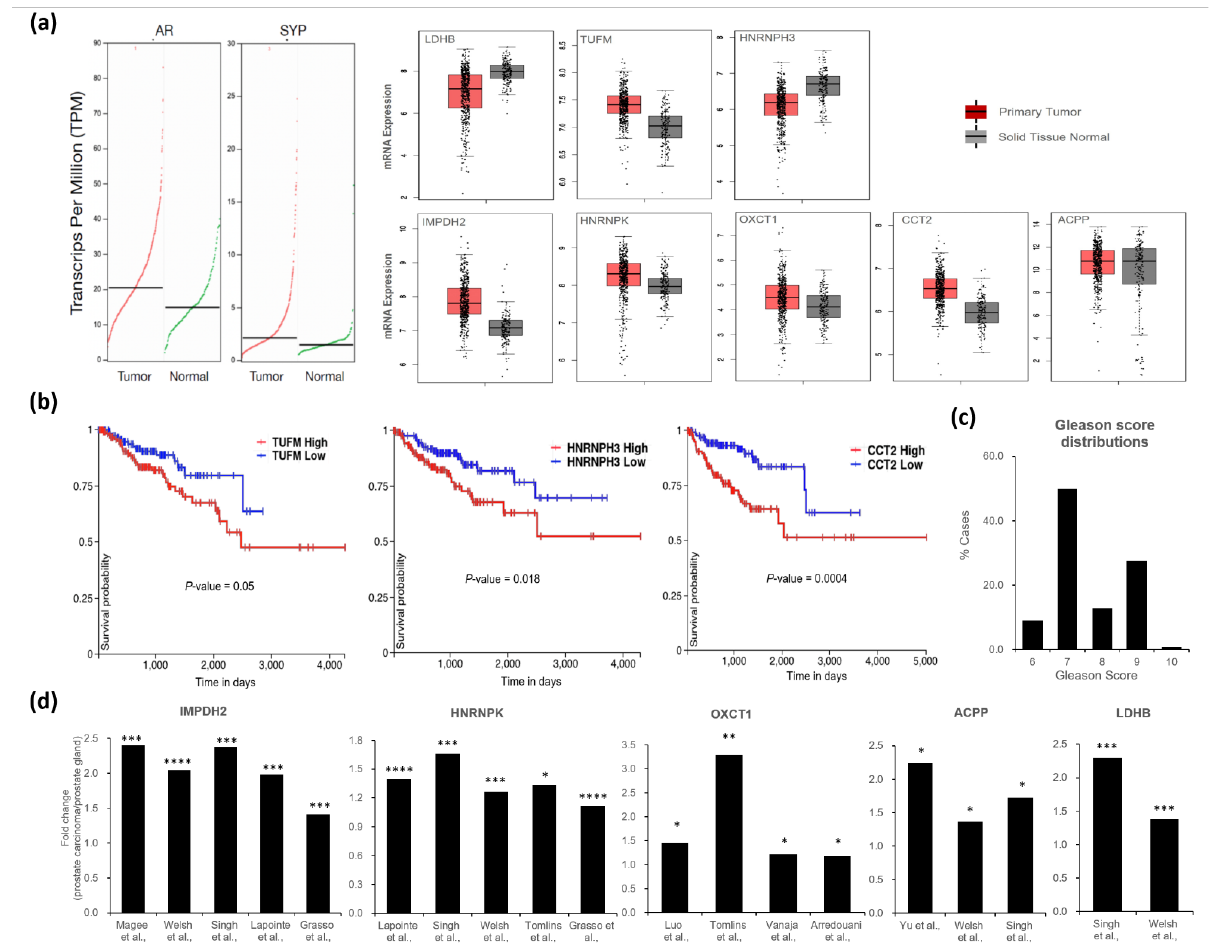
Figure 6. Protein expression and progression-free interval in prostate cancer patients. ( a ) Dot plots show the profiling of AR and SYP gene expression across tumor and paired normal samples, with each dot representing a distinct tumor or normal samples (left), and the relative expression of eight genes (right) was represented in normal tissues versus tumor tissues with a Gleason score ≥ 6. ( b ) Kaplan-Meier curves show that changes in the mRNA expression of DHT- and FSK-regulated proteins are associated with clinical outcomes in samples from the TCGA PRAD database ( n = 550; log-rank p -value < 0.05). ( c ) Gleason score distribution was represented from patients used in this study. ( d ) Differences in gene expression were quantified as fold changes in prostate carcinomas, including hormone refractory prostate cancer and metastatic prostate cancer samples compared with prostate gland samples from various datasets [57–66] (* p < 0.05, ** p < 0.01, *** p < 0.001, **** p <